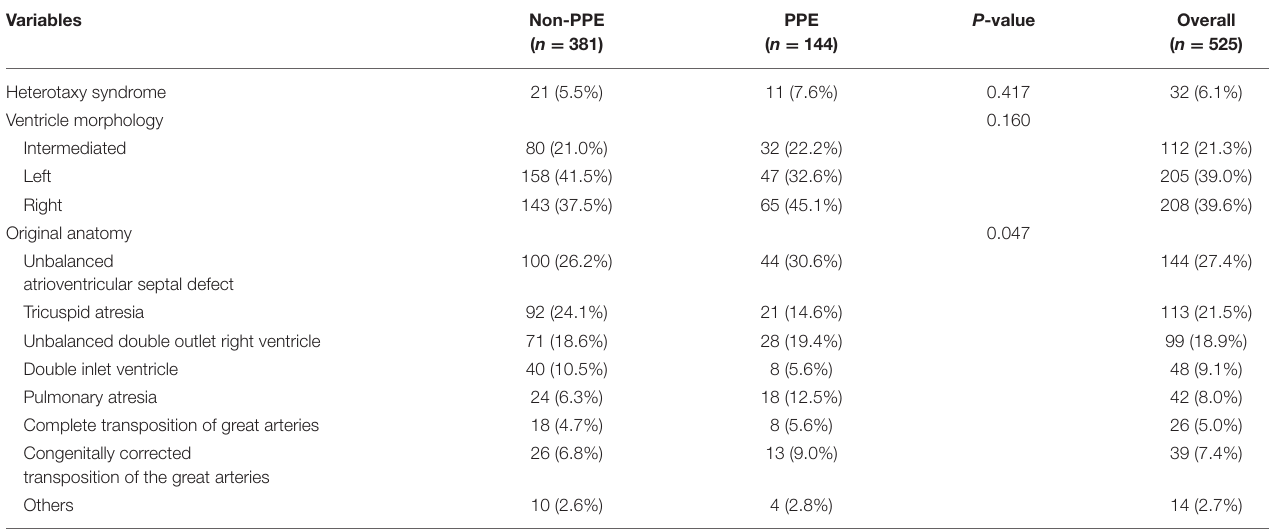
TABLE 3 | The anatomy characteristics of the study